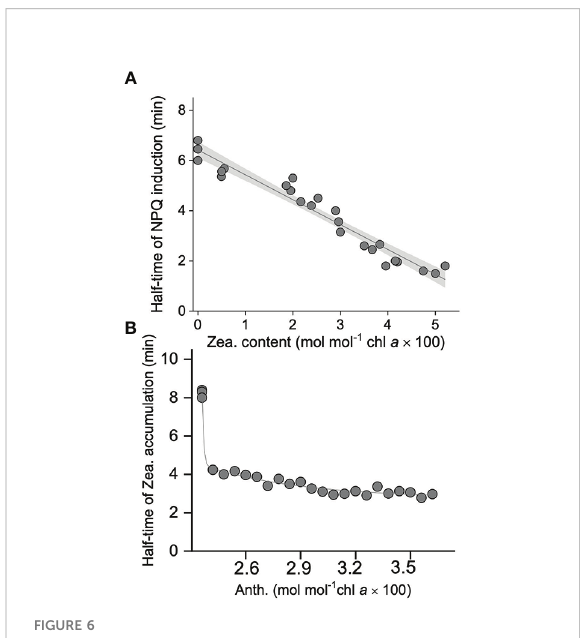
FIGURE 6 (A) Correlation between the half-time of non-photochemical quenching (NPQ) (min) and retained zeaxanthin content (Zea., mol mol – 1 Chl a × 100). (B) Correlation between the half-time of zeaxanthin accumulation (min) and retained antheraxanthin content (Anth., mol mol – 1 Chl a × 100). All these data are collected from the high light treatments (1200 umol photons m -2 s -1 ) with pre-illuminated blades of S. thunbergii . The solid line and gray shadow in A represent the fi t of data to a linear model ( p < 0.01 and R 2 = 0.97; n = 24) and the 95% con fi dence interval, respectively. The solid line in B represents the fi t of data to an exponential model ( p < 0.01 and R 2 = 0.97, n =